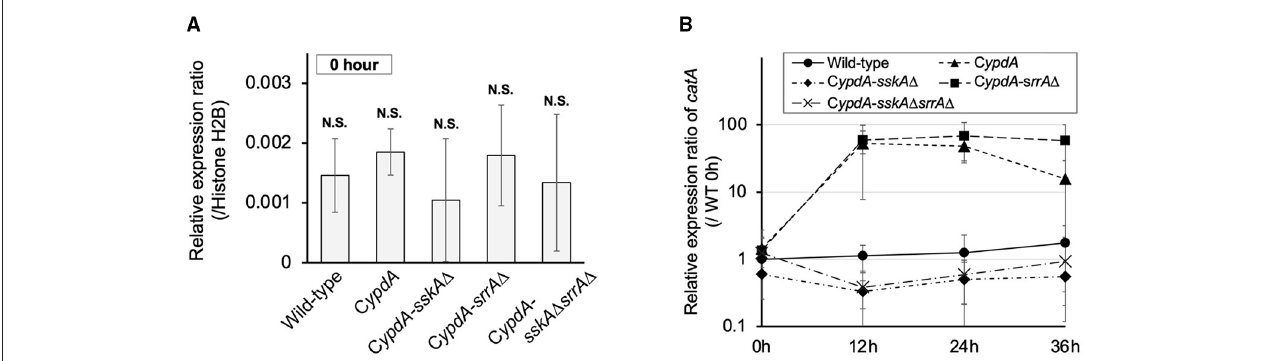
FIGURE 2 | Expression levels of catA in Aspergillus nidulans wild-type, C ypdA , and C ypdA -derivative strains. (A) Quantitative real-time PCR analysis. Conidia (final concentration, 5 × 10 5 conidia/ml) were inoculated into ypdA -inducing CDTFY medium and cultured for 20h before transfer to ypdA -repressing CDY medium, at 0h. Transcript levels of catA were quantified by RT-PCR. Each value represents the expression ratio relative to the gene encoding H2B in each strain. Error bars represent standard deviations from three independent replicates. N.S., not significant. (B) Time course of catA expression after transfer from ypdA -inducing medium (CDTFY; 0h) to ypdA -repressing medium (CDY). Samples were prepared from mycelia at 12, 24, and 36h, and expression of catA was quantified by RT-PCR. The expression level of the catA gene in each sample was normalized to that of the histone H2B gene (internal control) in the same sample. Each value represents the catA expression ratio relative to expression in the wild-type strain cultured in CDTFY medium for 20h (WT 0h). Error bars represent standard deviations from three independent